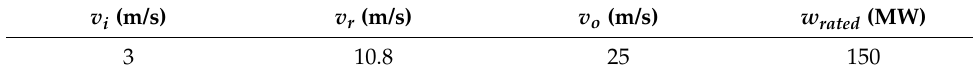
Table A2. Parameters of the wind